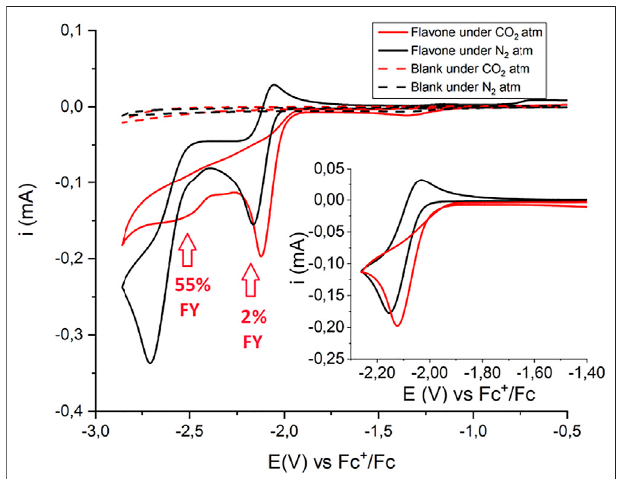
FIGURE 2 | CV of 5 mM Flavone in CH 3 CN with 0.1 M tetrabutylammonium hexa fl uorophosphate supporting electrolyte under N 2 (black traces) and CO 2 (red traces). The inset shows the scan conducted in a narrow potential range and limited to the fi rst reduction process. Glassy carbon working electrode (GC, 0.3 cm diameter, 0.07 cm 2 geometric area), Pt counter electrode, Ag/AgCl reference electrode, scan rate 0.1 V s − 1